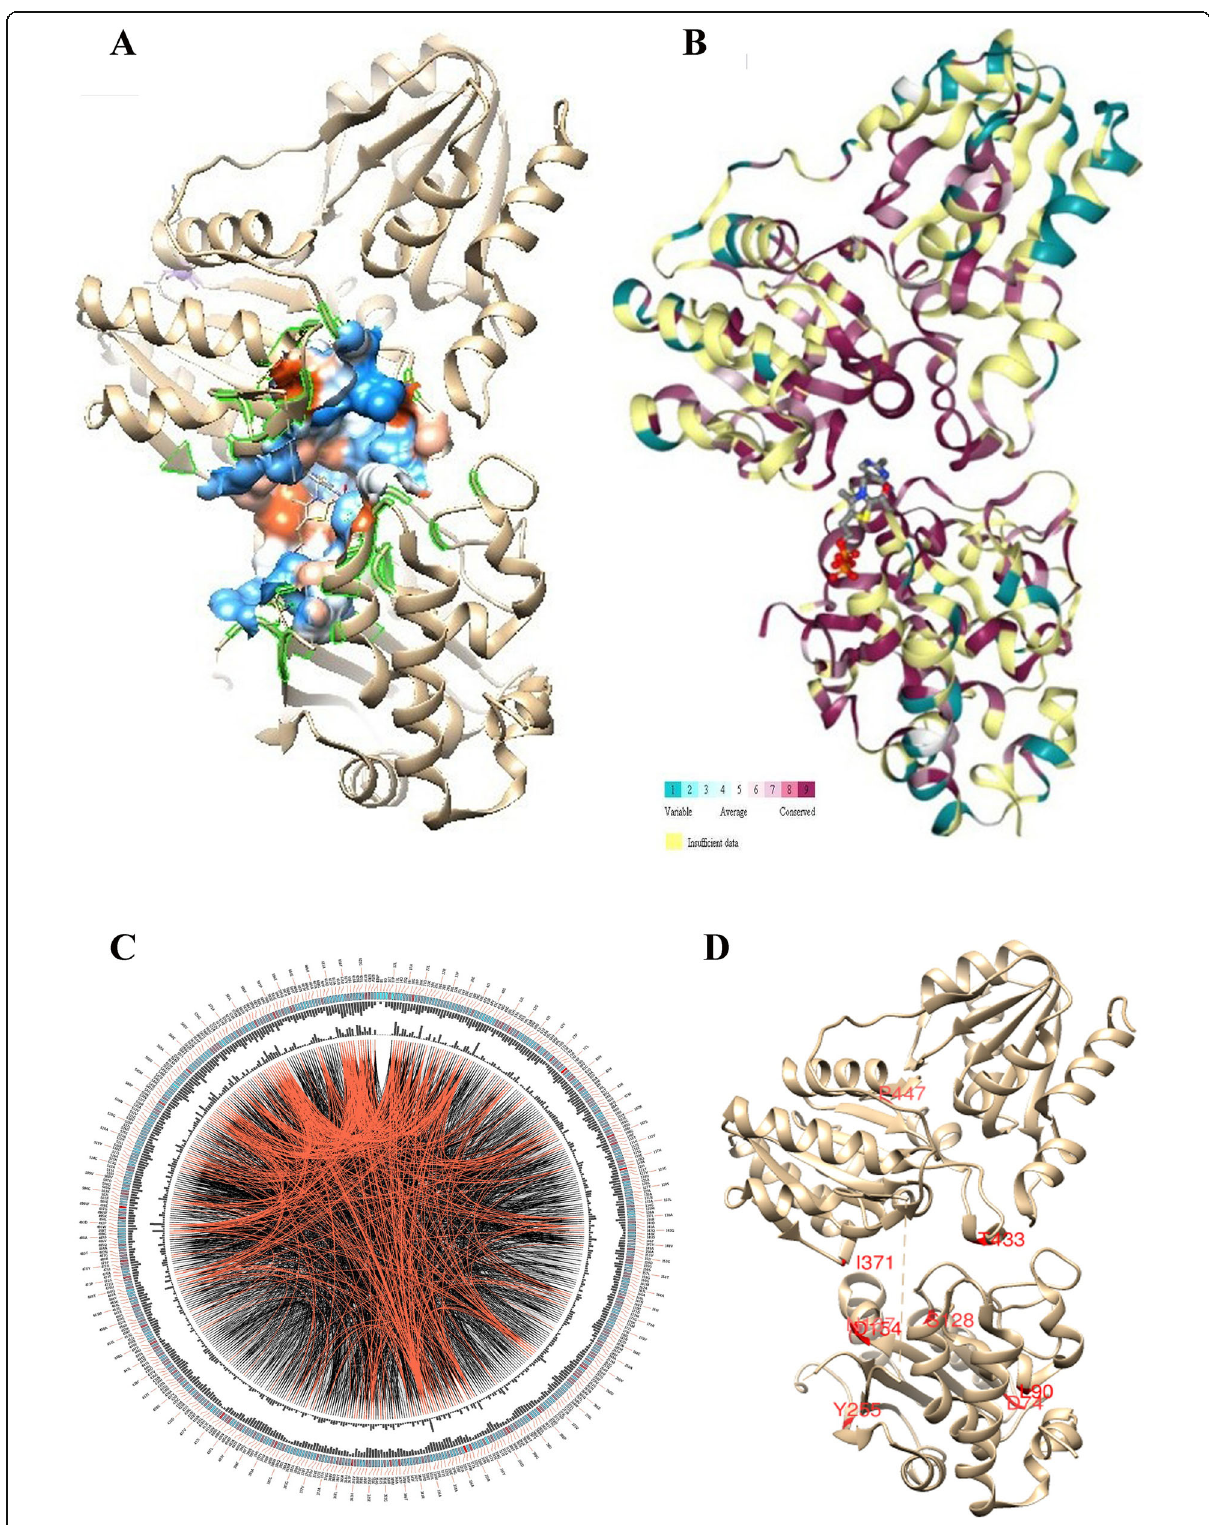
Fig. 10 (See legend on next